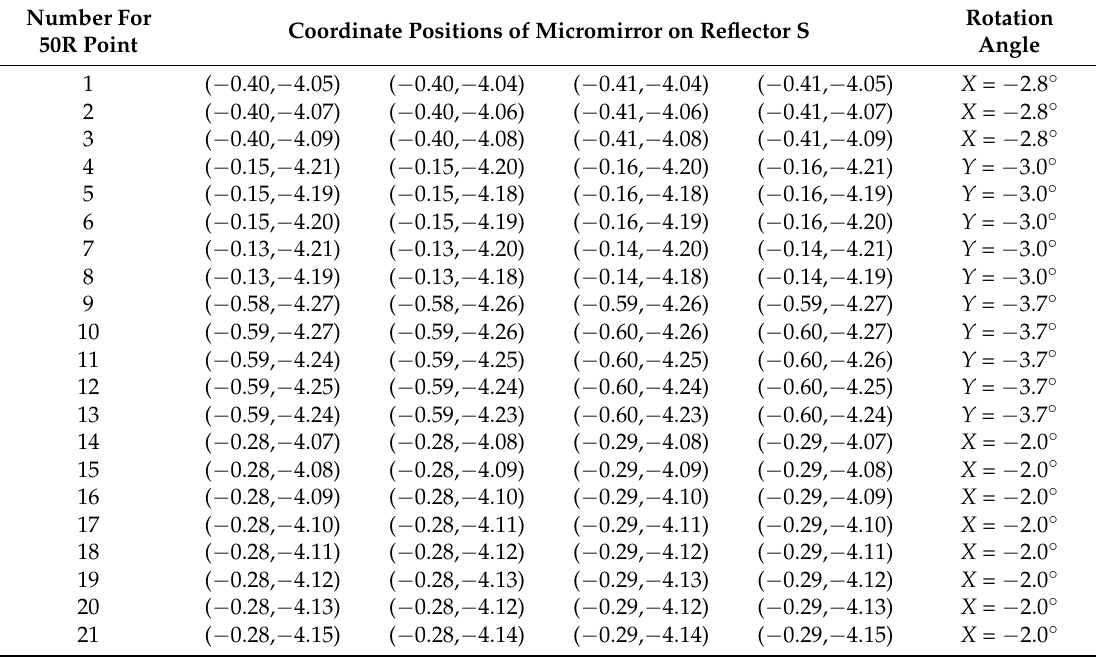
Table 3. Coordinate positions and rotation angles of the 12 micromirrors used for compensation “Point 75R”